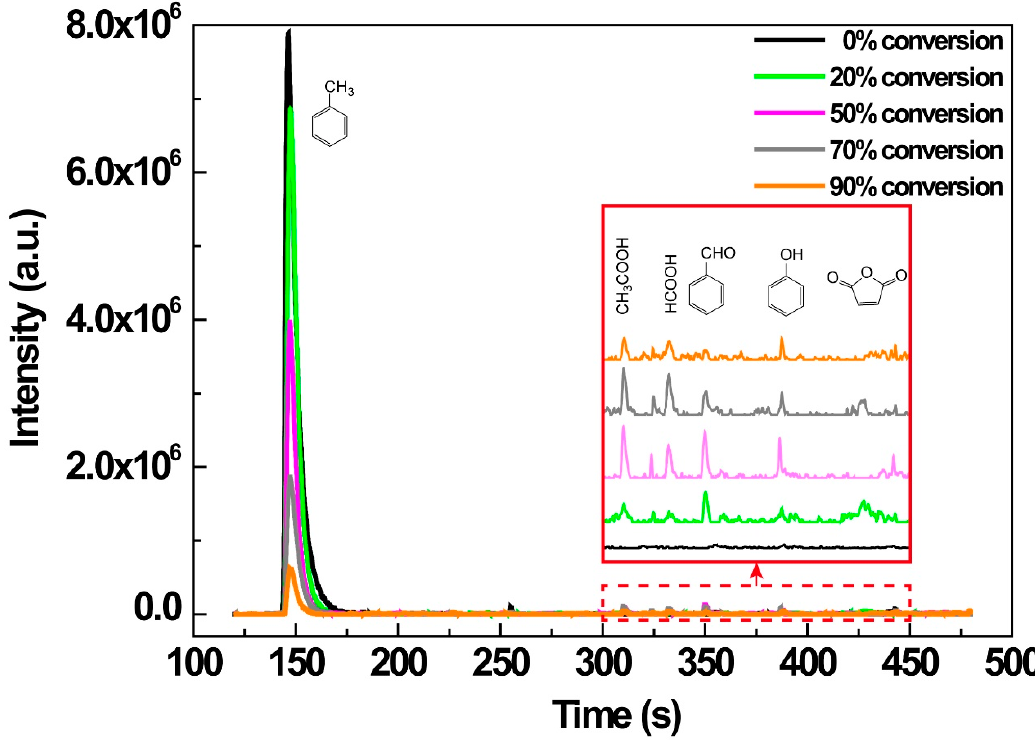
Figure 8. TIC diagrams of main toluene degradation intermediates under different toluene conversions using GC-TOF-MS.